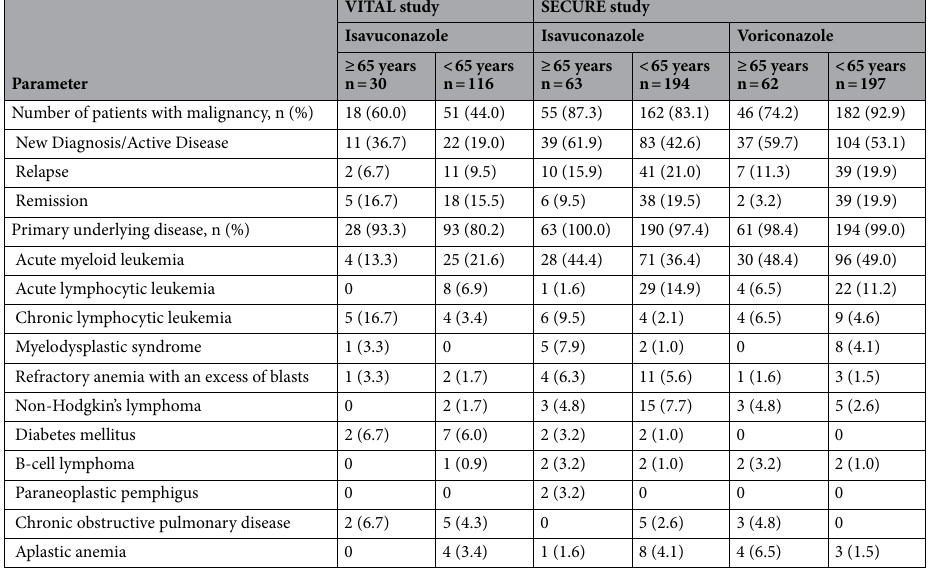
Table 2. Primary underlying disease or condition (safety population). Primary underlying disease in ≥ 3.2% of the patients in at least one of the studies are listed. n number of patients.